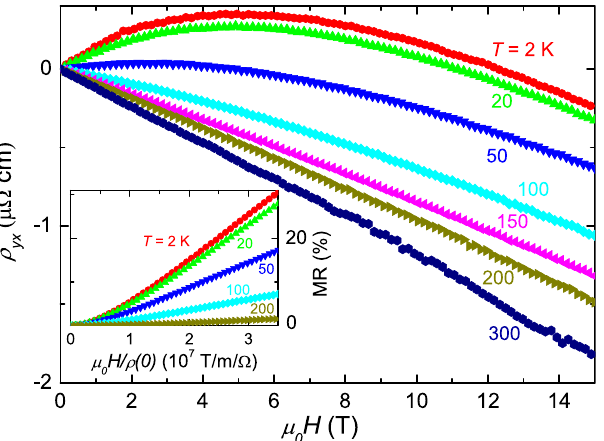
Figure 3. Hall resistivity and Kohler plot for NbTe 4 . Field dependence of Hall resistivity ( ρ yx ) under various temperatures. The current is along the c -axis, and the field is along the b -axis. The inset: Kohler’s rule by plotting the MR vs. μ ρ H / (0) from 2 K to 200 0